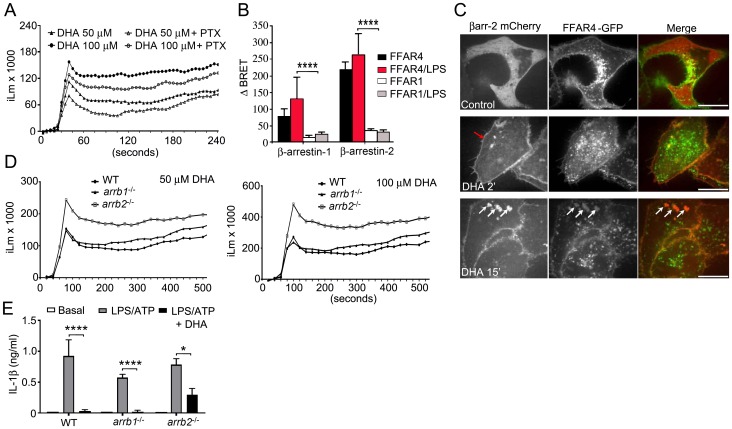
DHA elicits a calcium flux and its suppression of inflammasome activity partially depends upon β-arrestin2 not β-arrestin1.(A) DHA elicited changes in intracellular Ca2+ in BMDMs treated with pertussis toxin (200 ng/ml), or not, for 2 hours prior to the assay. (B) BRET analysis using HeLa cells expressing a BRET donor (RLuc-β-arrestin1 or β-arrestin2-RLuc) and increasing amounts of a BRET acceptor (FFAR4-GFP or FFAR1-GFP) stimulated with LPS, or not, prior to addition of DHA. The BRET ratios were calculated and the change in BRET determined. (C) Confocal microscopy of HeLa cells expressing FFAR4-GFP and β-arrestin-2 mCherry following exposure to DHA. Red arrow indicates β-arrestin-2 recruitment and the white arrows intracellular co-localization of β-arrestin-2 and FFAR4. Scale bar is 10 µM. (D) Intracellular calcium response to DHA of BMDMs prepared from wild type and β-arrestin knock-out mice. (E) ELISA to measure IL-1β in cell supernatants conditioned by LPS primed and ATP treated BMDMs from WT, arrb1
−/−, and arrb2
−/− mice. DHA (100 M) was added at the priming step. Results are from 3 independent experiments. * P<0.05, ****P<0.0001.